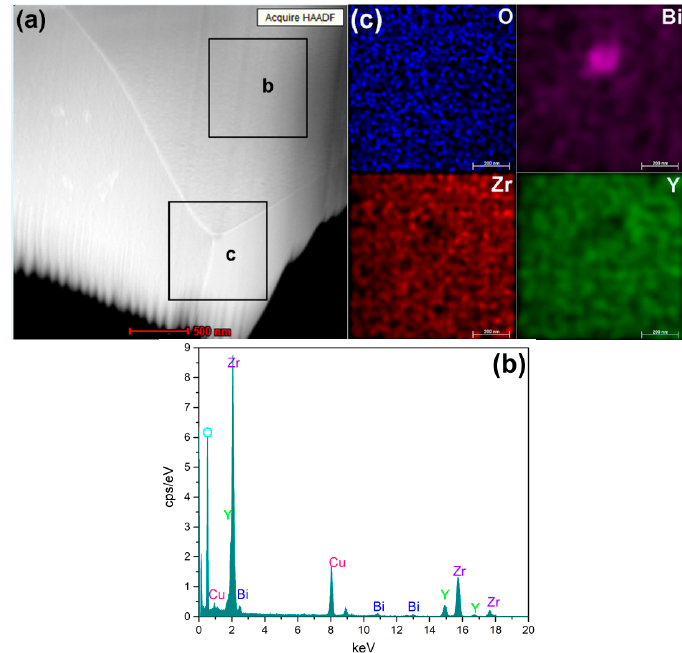
Figure 6. Selected area electron diffraction pattern of 2Bi-10YSZ sampled sintered at 1300 °C: ( a ) FCC zone axis [011]; ( b ) FCC zone axis [001].